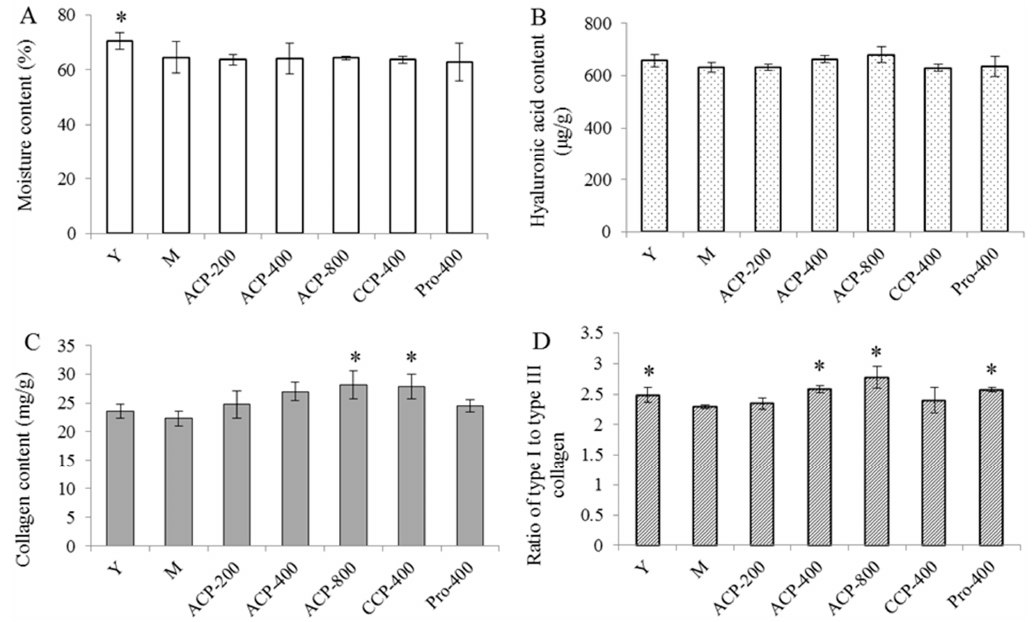
Figure 3. Moisture content ( A ), hyaluronic acid content ( B ), hydroxyproline content ( C ) and ratio of type I to type III collagen ( D ) of chronologically aged mice after the administration of collagen